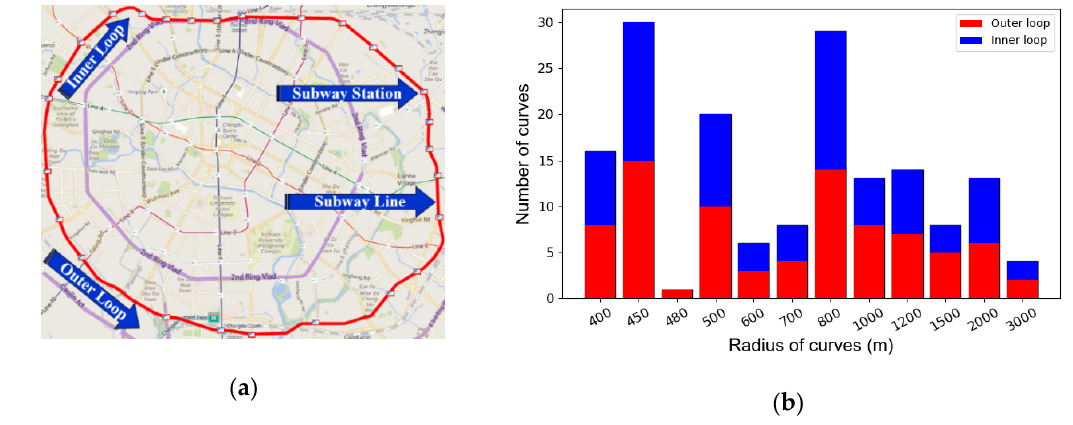
Figure 3. Line 7 of the Chengdu Metro, China: ( a ) Overview; ( b ) Radius of curves.